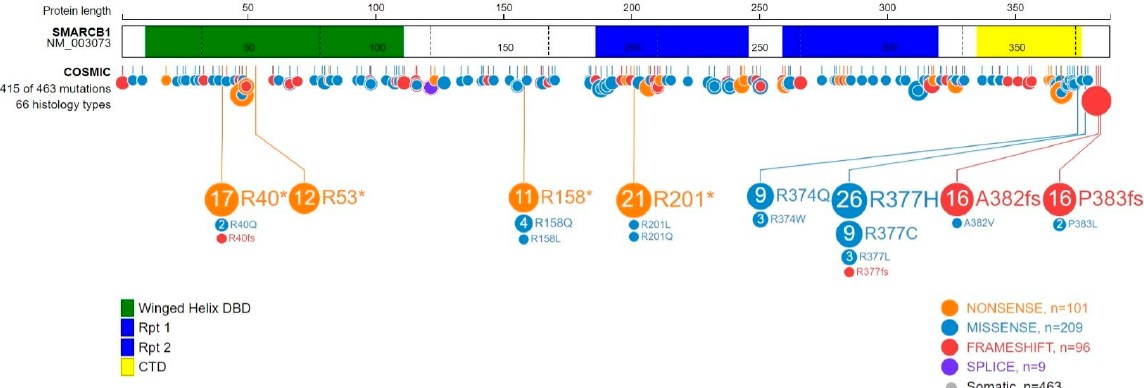
Figure 1. Schematic representation of SMARCB1 functional domains and summary of pathogenic somatic mutations (COSMIC). The SMARCB1 protein contains four functional domains: a winged helix domain DNA-binding domain, DBD (aa10-110), two highly conserved imperfect repeat domains, Rpt1 (aa186-248) and Rpt2 (aa259-319) and the highly conserved putative coiled-coil C-terminal α helix domain, CTD (aa335-375). Synonymous mutations have been excluded. Number of the most frequent pathogenic somatic mutations found in COSMIC are indicated.